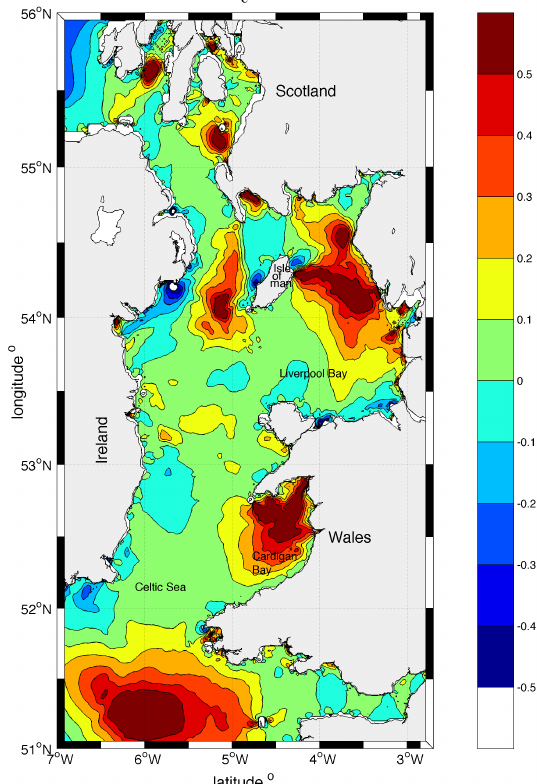
Fig. 4. Bathymetry of the Irish Sea used by POLCOMS.